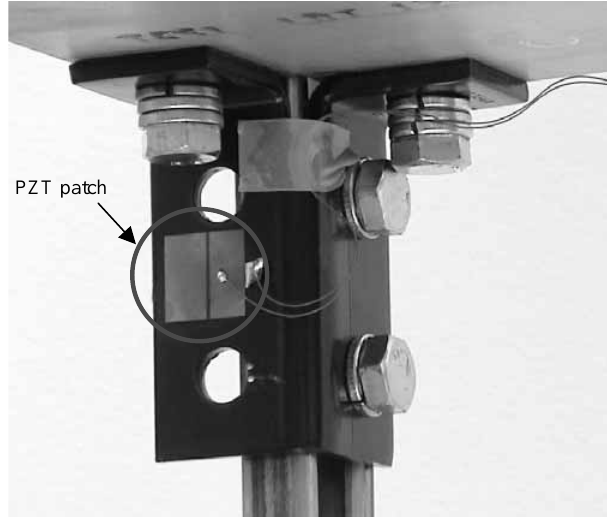
Fig. 2. Close-up of Joint 3 with PZT patch bonded to